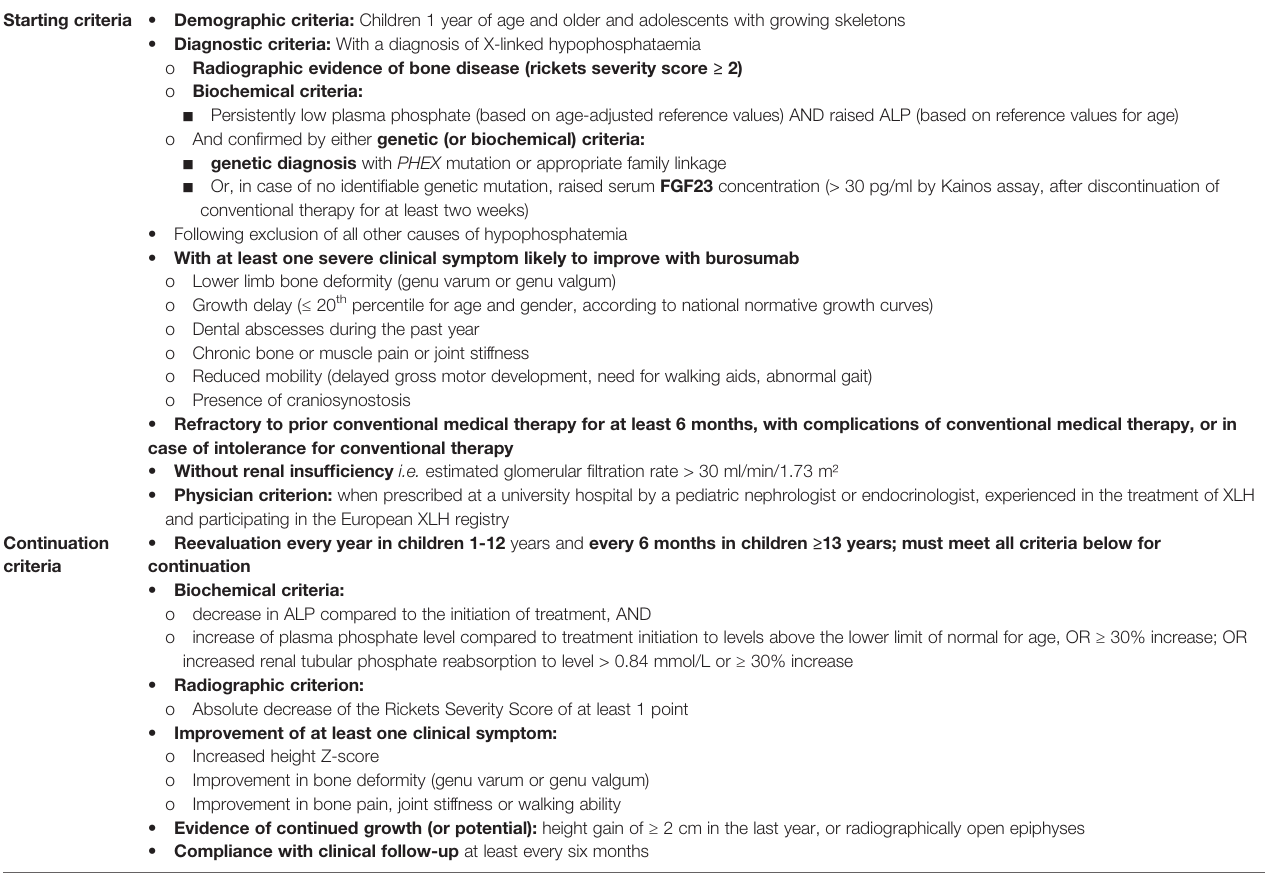
TABLE 3 | Reimbursement criteria for burosumab in children in Belgium as of January 2021. Starting criteria (cid:129) Demographic criteria: Children 1 year of age and older and adolescents with growing skeletons (cid:129) Diagnostic criteria: With a diagnosis of X-linked hypophosphataemia o Radiographic evidence of bone disease (rickets severity score ≥ 2) o Biochemical